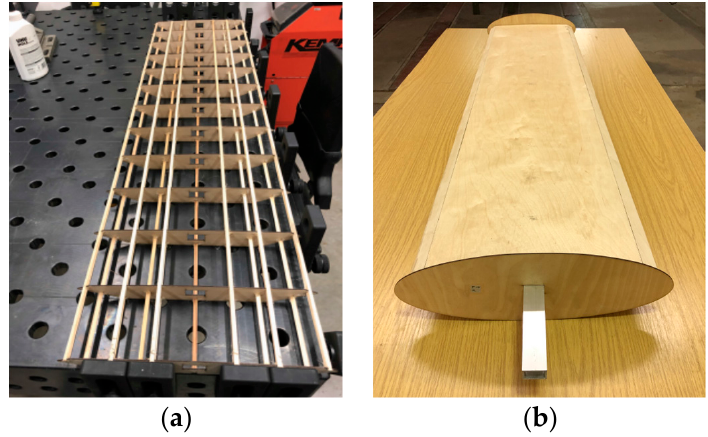
Figure 6. ( a ) Great Belt Bridge deck cross-section; ( b ) skeleton of the bridge deck model.